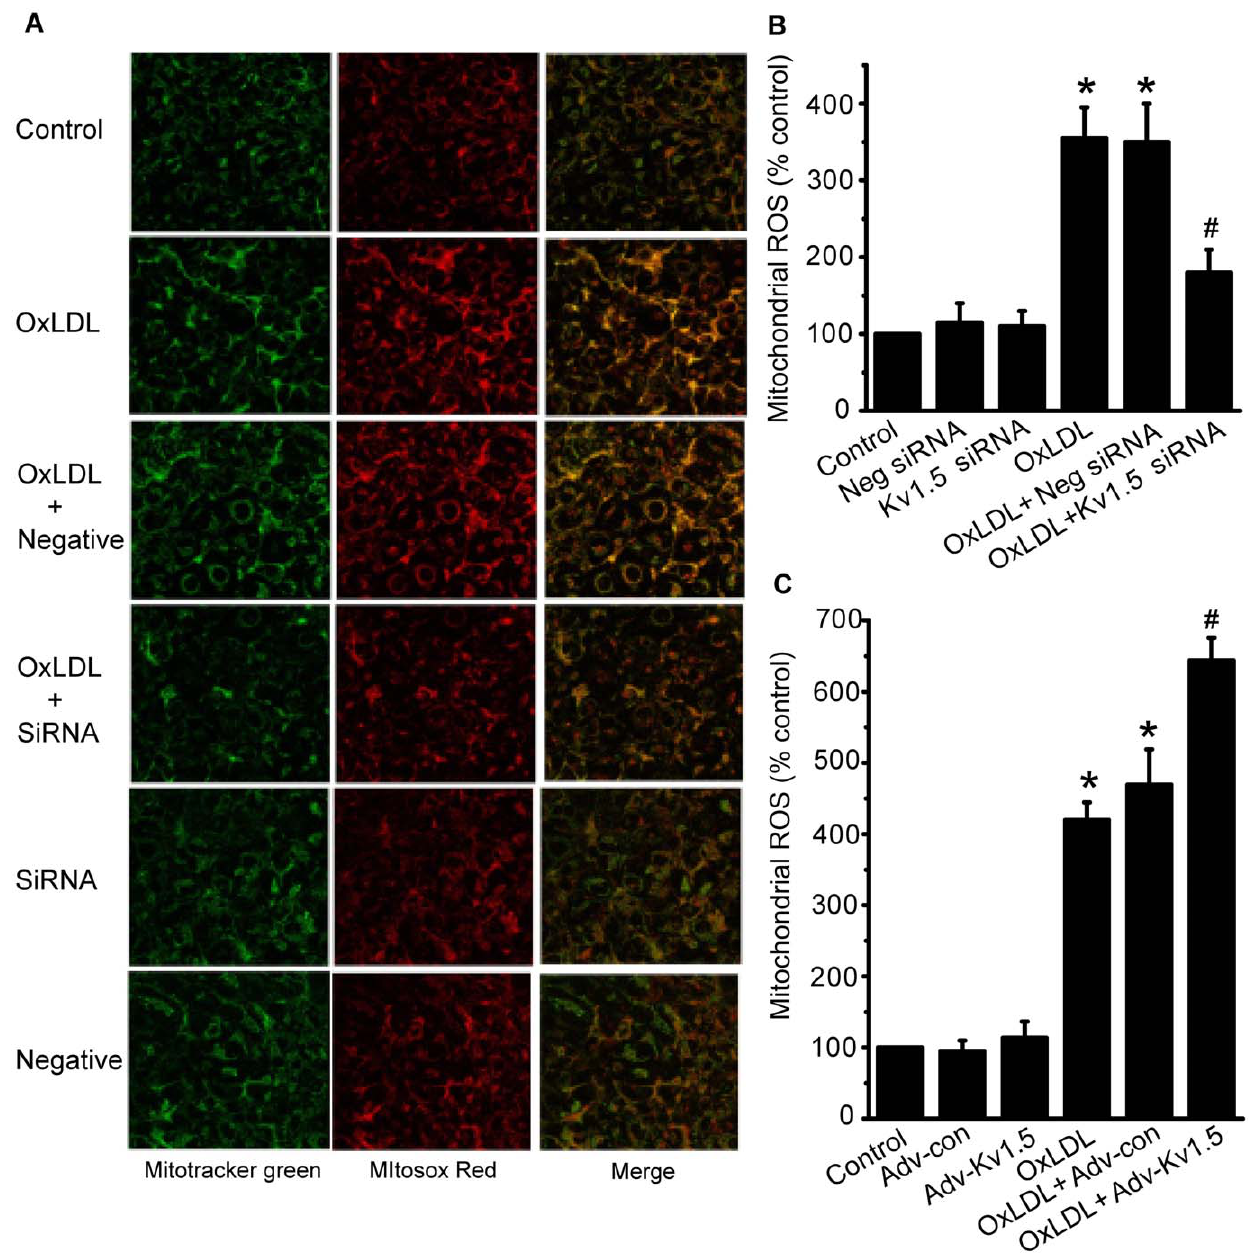
Figure 6. OxLDL-induced mitochondrial ROS overproduction was attenuated by Kv1.5 siRNA, but exaggerated by Kv1.5 overexpression. The mitochondrial ROS generation was detected using MitoSOX reagents in HPAECs transfected with Kv1.5 siRNA (10 nM) or infected with adnovirus containing KCNA5 , which were treated with oxLDL (150 m g/ml) for further 1 h. ( A ) The representative images from laser scanning confocal microscopy Kv1.5 siRNA significantly attenuated oxLDL-induced mitochondrial superoxide production in HPAECs. ( B ) & ( C ). The mitochondrial ROS levels in HPAECs transfected with Kv1.5 siRNA (B) or infected with adnovirus overexpression of Kv1.5 (C) were quantified by the fluorescent plate reader and expressed as the ratio of MitoSOX to Mitotracker. The values are presented as means 6 SEM of 6 independent experiments. * P , 0.05, ** P , 0.01 vs. Vehicle control; # P , 0.05, ## P , 0.01 vs. Ad-con. doi:10.1371/journal.pone.0049758.g006 thelial cell injury, accompanied by an increase in Kv1.5 protein expression and intracellular ROS production. To further confirm the importance of Kv1.5 for EC injury process, we applied adenovirus–mediated Kv1.5 gene transfer and siRNA specific for human Kv1.5 aiming to regulate endogenous Kv1.5 protein in EC models. In oxLDL-induced endothelial cell injury model, trans- fection of Kv1.5 siRNA into HPAECs could attenuate cellular